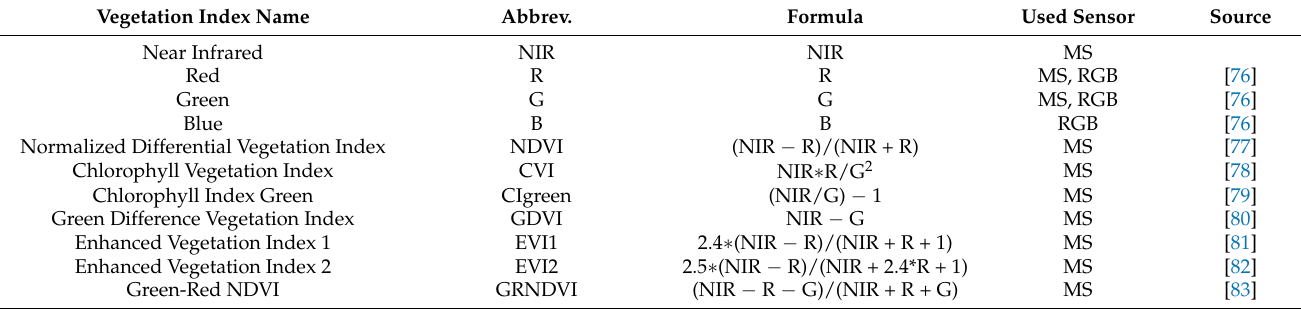
Table 3. Vegetation indices used in this